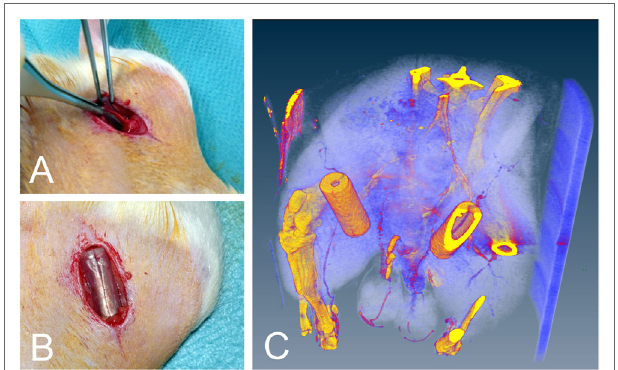
FIGURe 1 | (A) Location of the vascular bundle before implantation. (B) Implanted silicone tubes. (C) Silicone tube in situ micro CT image. Note the perfused epigastric vascular bundle passing through the tube. The CT scan was performed in a single animal only to visually present the implantation and was not included in the